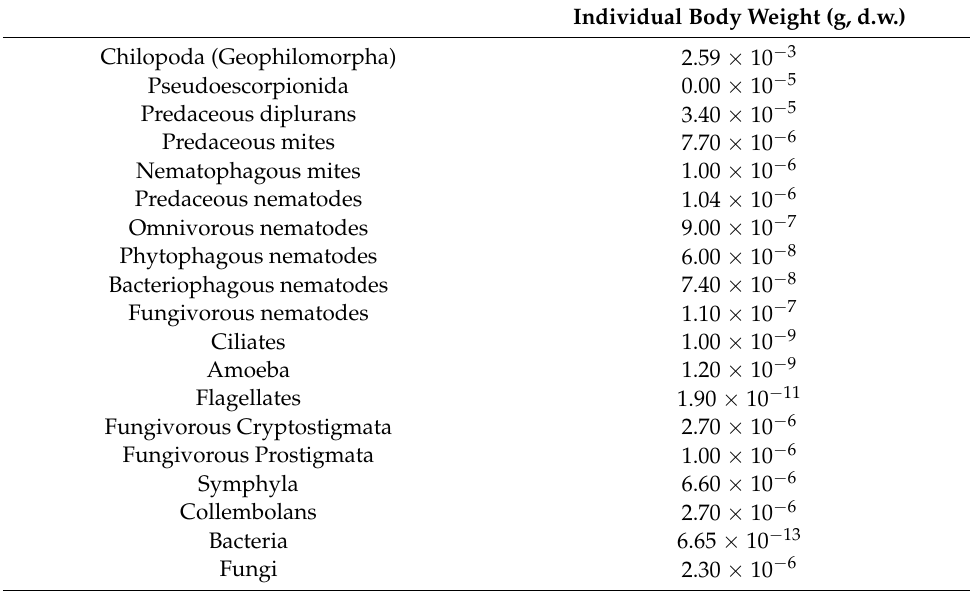
Table A1. Individual body weight of the trophic groups found in the soil of the three vineyards. Individual Body Weight (g,